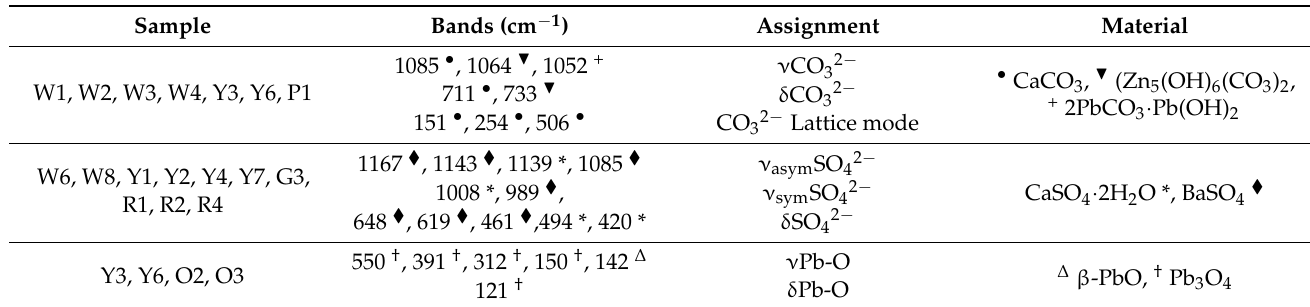
Table A1. Summary of the main Raman bands and their tentative assignment of inorganic pigment present in sample-case [38–46,49–52,55,56,59,60]. • = Calcite,